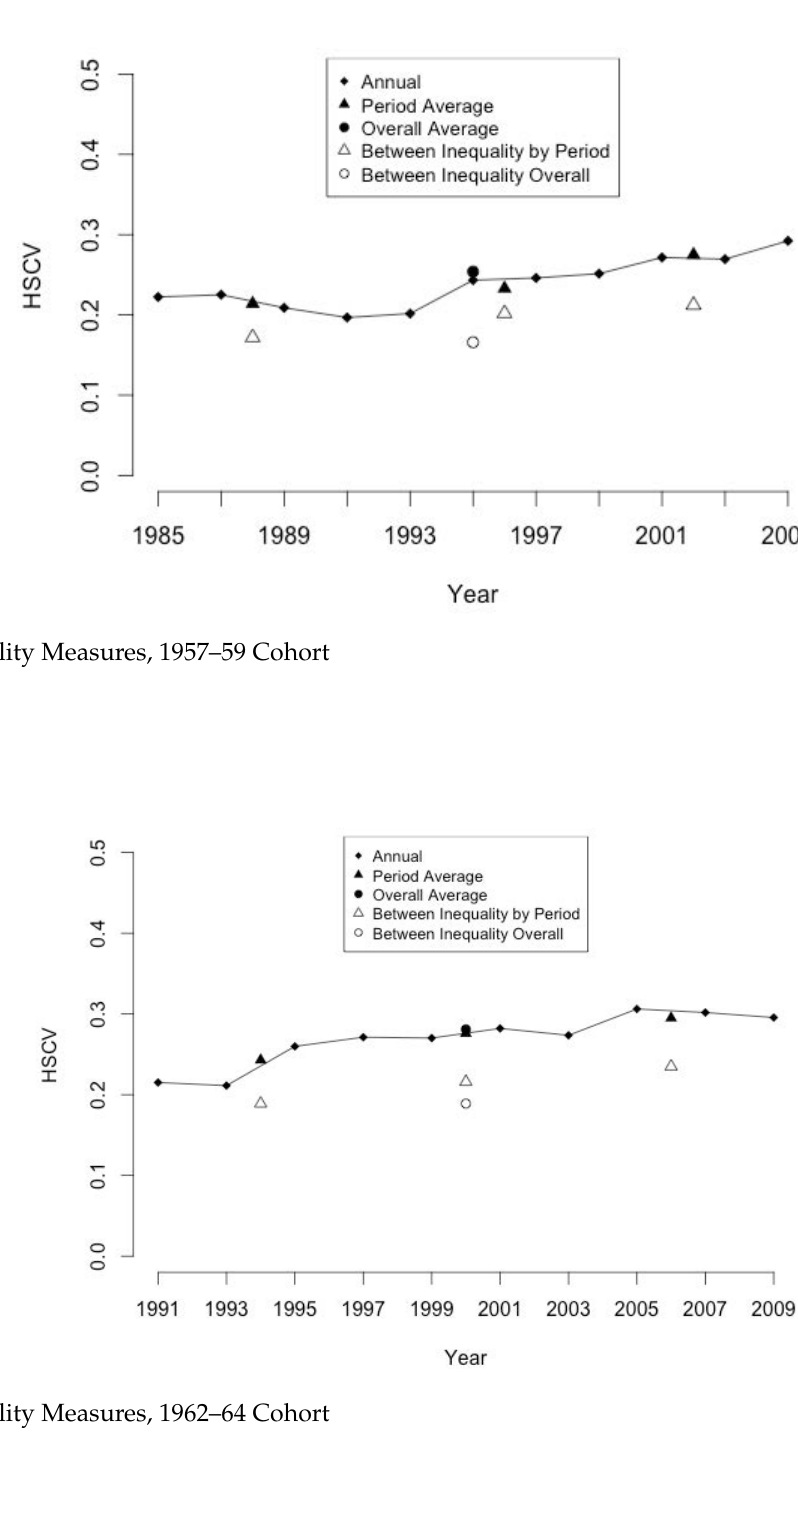
sociological science | www.sociologicalscience.com